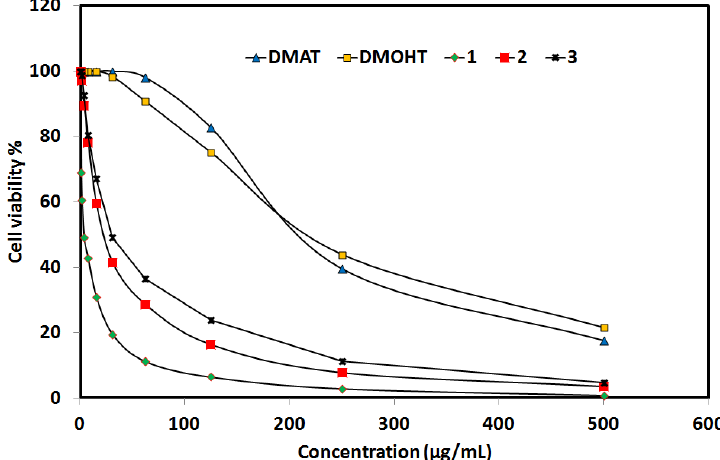
Figure 13. The anticancer activity of the studied compounds versus Lung carcinoma .